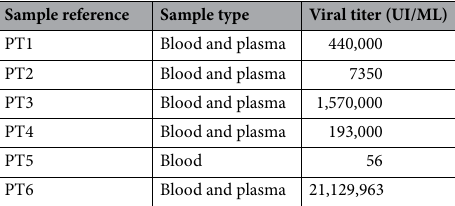
Table 1. Characteristics of the study